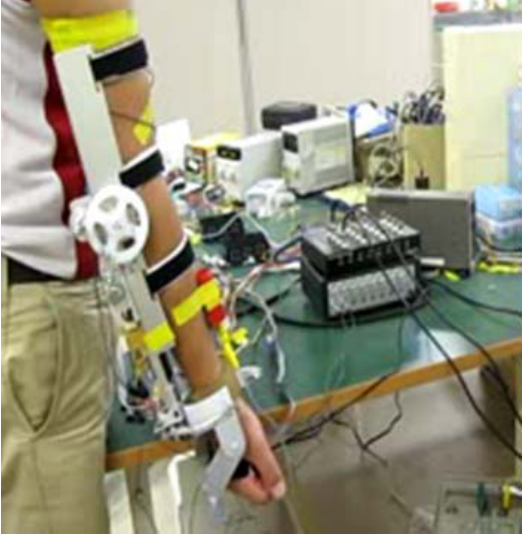
Figure 11. Subject wears the exoskeleton device with the MTx sensor fixed on his upper